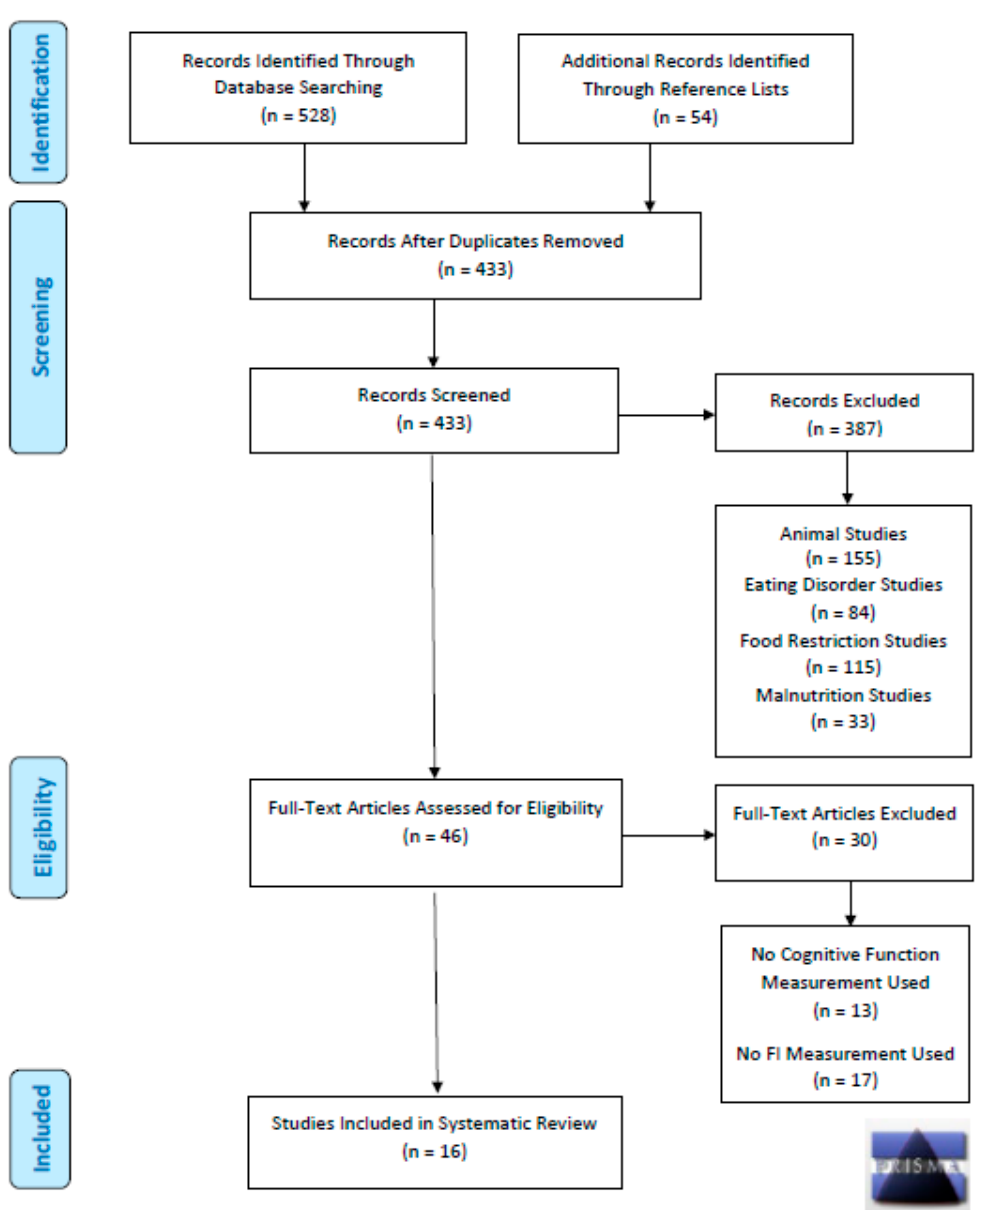
Figure 1. PRISMA Diagram– Search Strategy for Systematic Review on Food Insecurity and Cognitive Function.